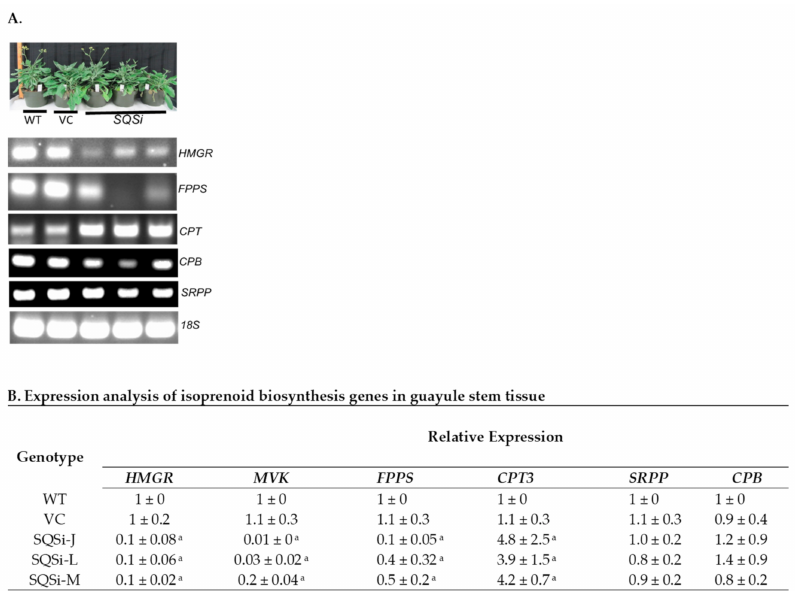
Figure 6. ( A ) Relative expression of metabolic and putative NR biosynthesis and structural genes in SQSi lines’ background. Plant phenotypes for controls and SQS lines, RT-PCR for the isoprenoid pathway, and natural rubber biosynthesis-associated genes. ( B ) Quantitative expression of isoprenoid biosynthesis genes. Expression levels in stem tissue were compared to WT and normalized to the 18S reference gene. Values are averages of three biological replicates +/ − SD; ( a ) indicates a significant difference in comparison to WT at p > 0.05. HMGR = 3-hydroxy-3methylglutaryl-coenzyme A reduc- tase; FPPS = farnesyl pyrophosphate synthase; SQS = squalene synthase; CPT = cis -prenyltransferase; SRPP = small rubber particle protein; CBP = CPT binding